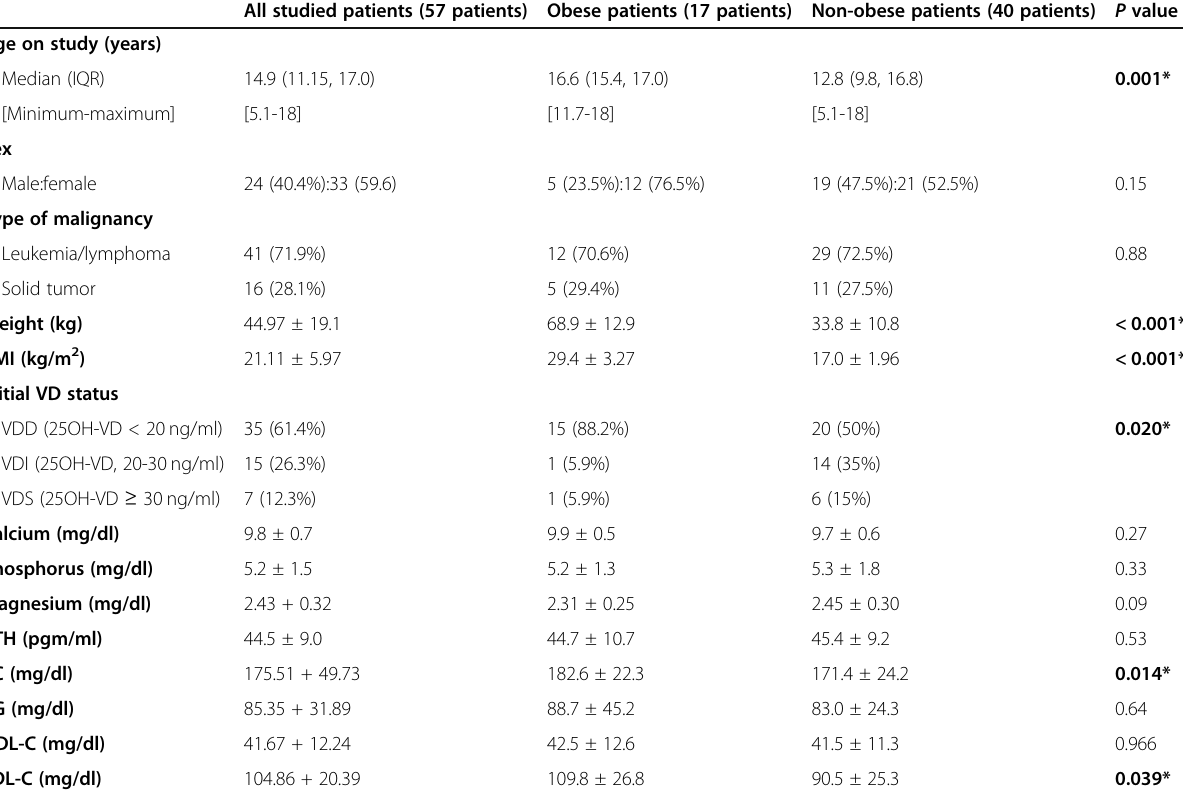
Table 1 Baseline characteristics, anthropometric, and laboratory data of the studied patients All studied patients (57 patients) Obese patients (17 patients) Non-obese patients (40 patients) P value